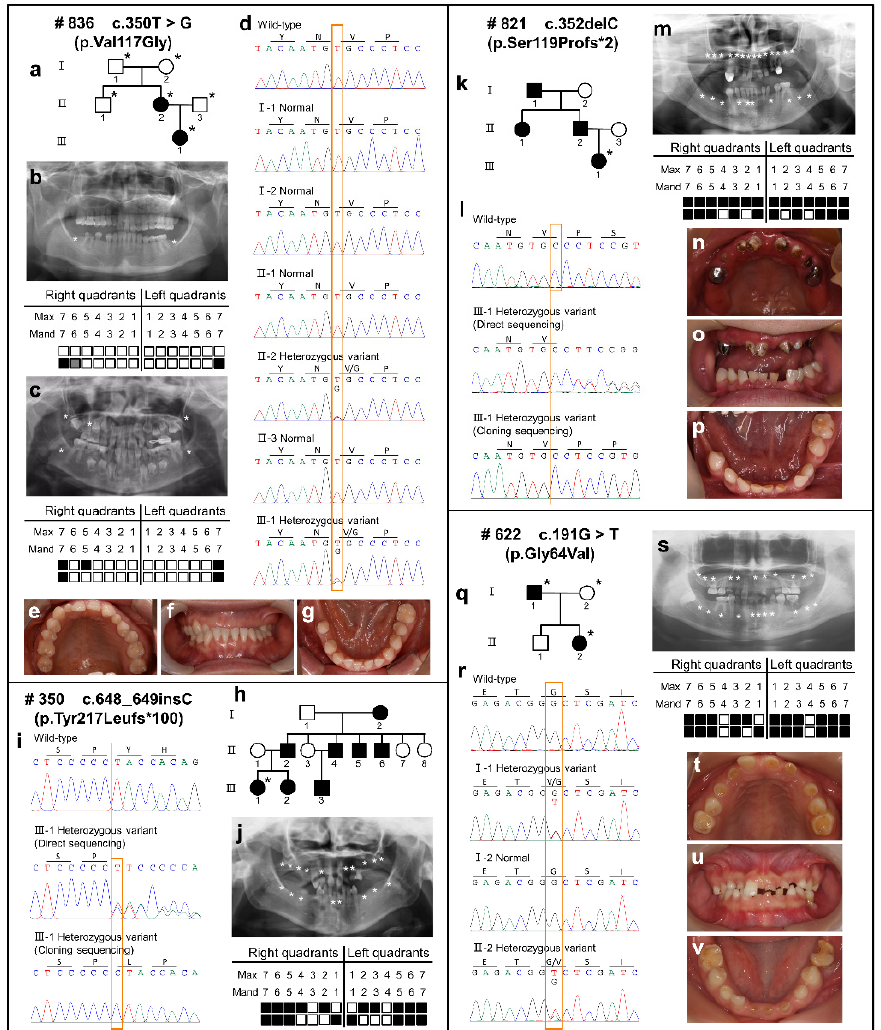
Figure 1. Pedigree, dental characteristics, and sequencing chromatograms of four families. ( a ) Pedigree of family #836. ( b ) Panoramic radiographs and schematic of #836 proband (II:1) with tooth agenesis. ( c ) Panoramic radiographs and schematic of #836 proband’s daughter (III:1) with tooth agenesis. ( d ) Sequencing chromatograms of available DNA in family #836 present a heterozygous PAX9 missense variant (c.350T > G; p.Val117Gly) identified in the proband (II:1) and her father (III:1). ( e – g ) Digital photographs of #836 proband (II:1). ( h ) Pedigree of family #350. ( i ) Sequencing chromatograms of available DNA in family #350 present a heterozygous PAX9 frameshift variant (c.648_649insC; p.Tyr217Leufs*100) identified in the proband (III:1). ( j ) Panoramic radiographs and schematic of #350 proband (III:1) with tooth agenesis. ( k ) Pedigree of family #821. ( l ) Sequencing chromatograms of available DNA in family #821 present a heterozygous PAX9 frameshift variant (c.352delC; p.Ser119Profs*2) identified in the proband (III:1). ( m ) Panoramic radiographs and schematic of #821 proband (III:1) with tooth agenesis. ( n – p ) Digital photographs of #821 proband (III:1). ( q ) Pedigree of family #622. ( r ) Sequencing chromatograms of available DNA in family #622 present a heterozygous PAX9 missense variant (c.191G > T; p.Gly64Val) identified in the proband (II:2) and her father (I:1). ( s ) Panoramic radiographs and schematic of #622 proband (II:2) with tooth agenesis. ( t – v ) Digital photographs of #622 proband (II:2). The arrow in the pedigree indicates the proband. The asterisks in the pedigree represent participating family members. Squares and circles with a slash in the pedigree represent individuals who have passed away. Asterisks in panoramic radiographs and black squares in the schematics indicate congenital missing permanent teeth. Gray squares in the schematics indicate extracted teeth. Mand, mandibular; Max, maxillary.